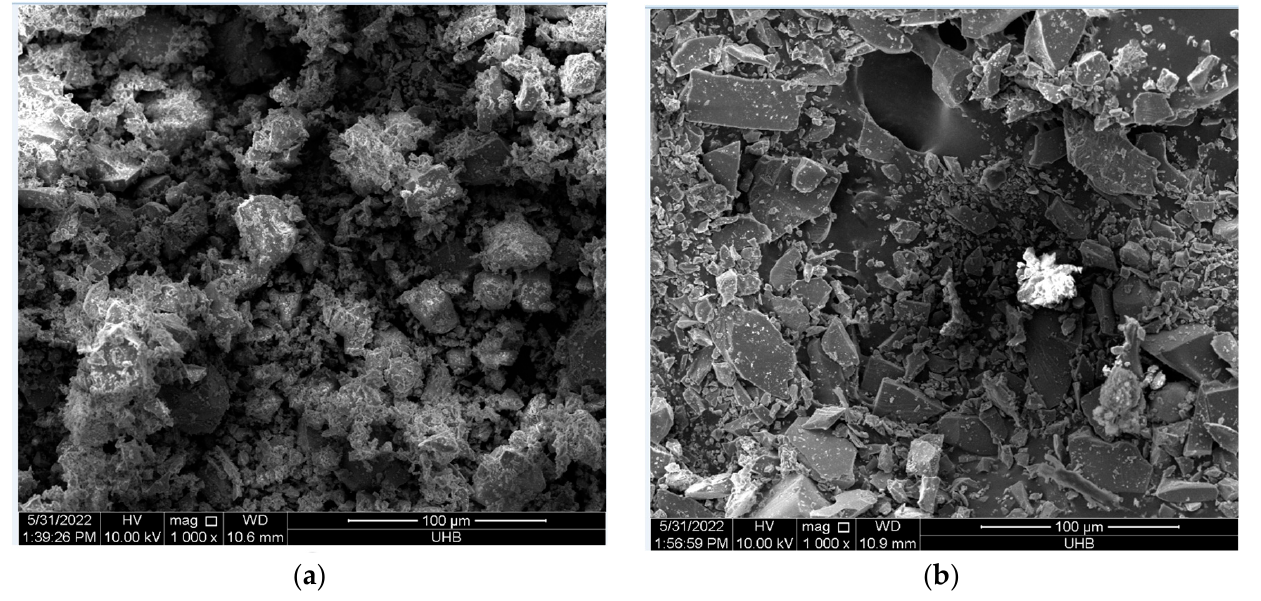
Figure 3. SEM micrographs of raw materials: ( a ) cement powder and ( b ) glass waste powder.